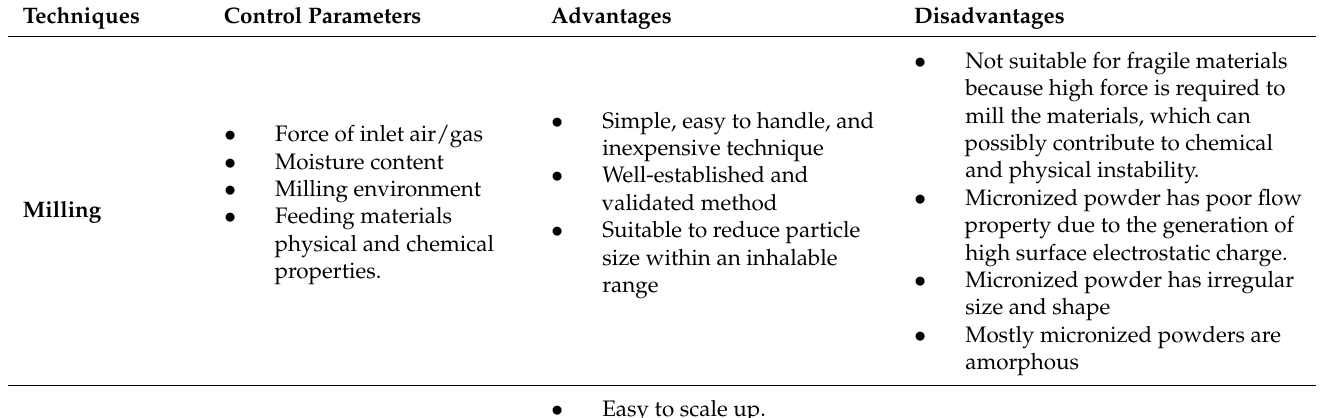
Table 1. Control parameters, advantages, and disadvantages of various